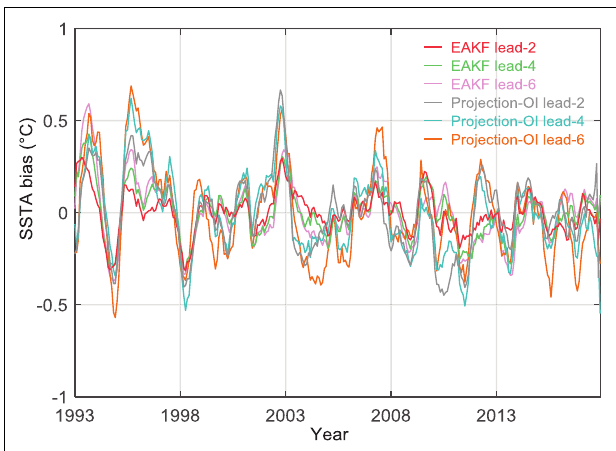
FIGURE 6 | Time series of area-averaged SSTAs prediction biases over the North Pacific (30–50 ◦ N, 150 ◦ E–150 ◦ W; units: ◦ C) with respect to OISST v2 for 1993–2017. The lines in different colors represent SSTA biases at the 2-, 4-, and 6-lead months in EAKF and Projection-OI predictions, respectively.